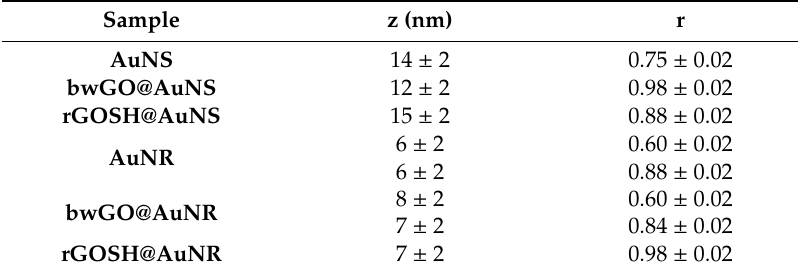
Figure 6. AFM micrographs of amplitude (top panels), height (middle panels, z scale = 15 nm), and section analysis curves (bottom panels) of: ( a ) AuNS, ( b ) bwGO@AuNS, ( c ) rGOSH@AuNS, ( d ) AuNR, ( e ) bwGO@AuNR, ( f ) rGOSH@AuNR. Arrows point to surfactant residues adsorbed on the mica substrates. Table 4. Average height (z, in nm) and aspect ratio (r) values calculated from the atomic force microscopy (AFM) micrographs images recorded in AC mode in air for the di ff erent